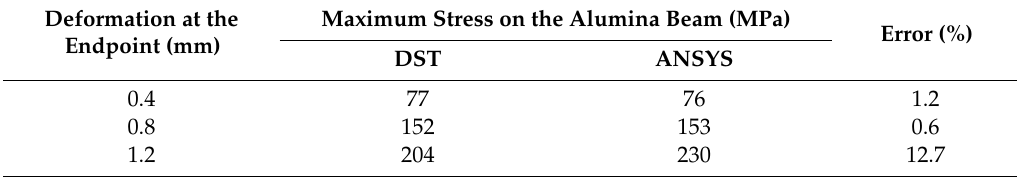
Figure 14. Stress of the alumina beam using the DST matrix. Table 8. Stress of the alumina beam using the DST matrix.